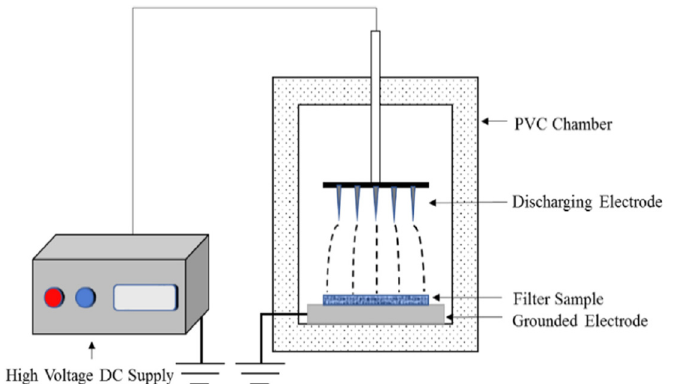
Figure 3. Set up for applying a corona discharge to a filter. (Reprinted with permission from [21]. Copyright 2020 Elsevier.).